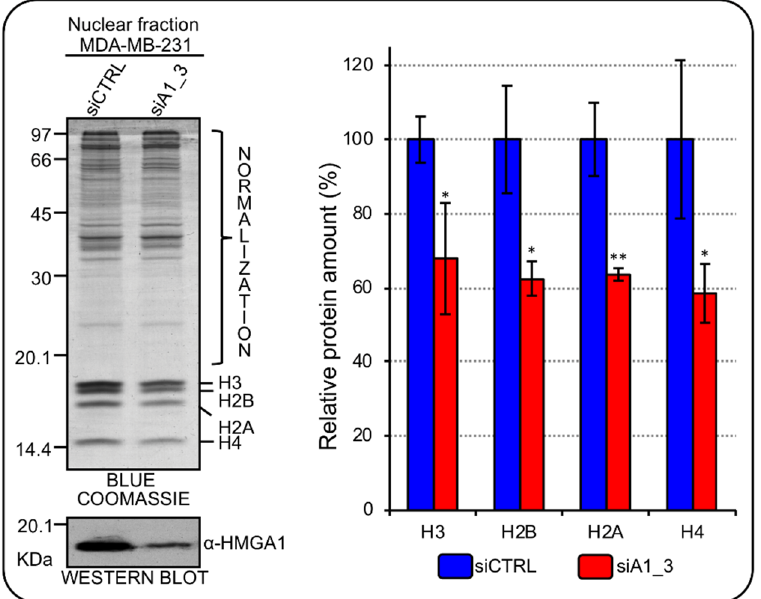
Figure 2. HMGA1 regulates core histones protein expression in MDA-MB-231 cells. Blue Coomassie stained gel was used to assess core histones protein amount in the nuclear fraction of MDA–MB–231 cells silenced for HMGA1 (siA1_3) and with control siRNA (siCTRL). The upper part of the gel (not including histones bands) was exploited for total protein normalization. The western blot below the Blue Coomassie staining confirms the silencing of HMGA1. Histogram graphs represent densitometric analyses (siCTRL versus siA1_3) of protein staining. The upper part of the stained gel was used to normalize the total amount of core histones. Bars indicate the mean. Standard deviations are shown ( n = 4). Statistical significance was assessed with Student’s t test (*: p ≤ 0.05; **: p ≤ 0.01).